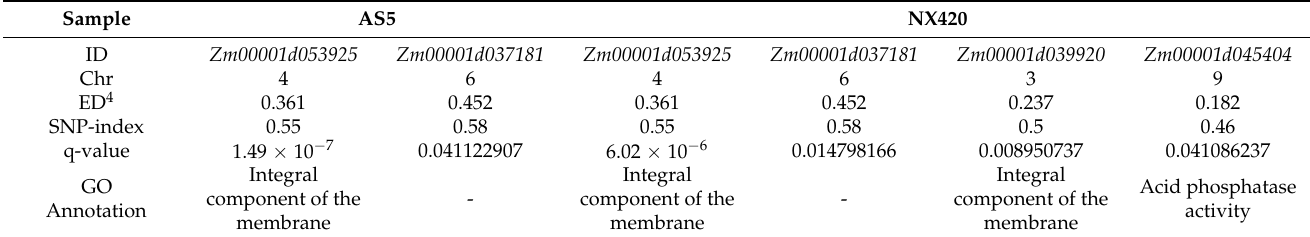
Table 4. The candidate genes’ overlapped BSA-seq and DEGs.